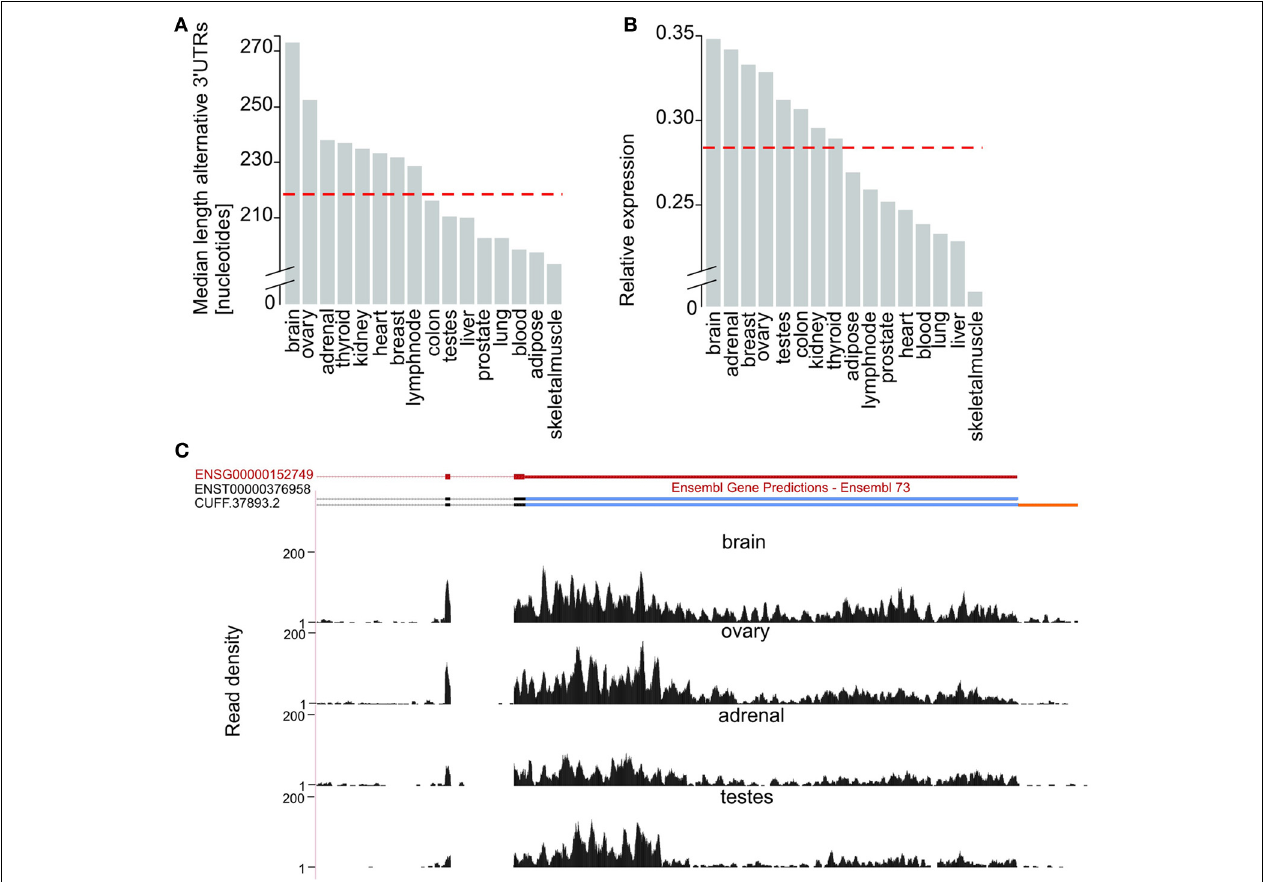
FIGURE 2 | Brain expressed isoforms have the longest 3 (cid:2) UTR extensions. (A) Median length (in nucleotides, Y-axis) of alternative 3 (cid:2) UTRs across 16 human tissues. The median across all non-neuronal tissues (219 nucleotides) is depicted as a horizontal dashed red line. (B) Median fold difference in expression (calculated as the number of reads per nucleotide of expressed sequence) of alternative relative to constitutive 3 (cid:2) UTR (Y-axis) across 16 tissues. The median across all non-neuronal tissues (median relative expression = 0.28) is depicted as a horizontal dashed red line.